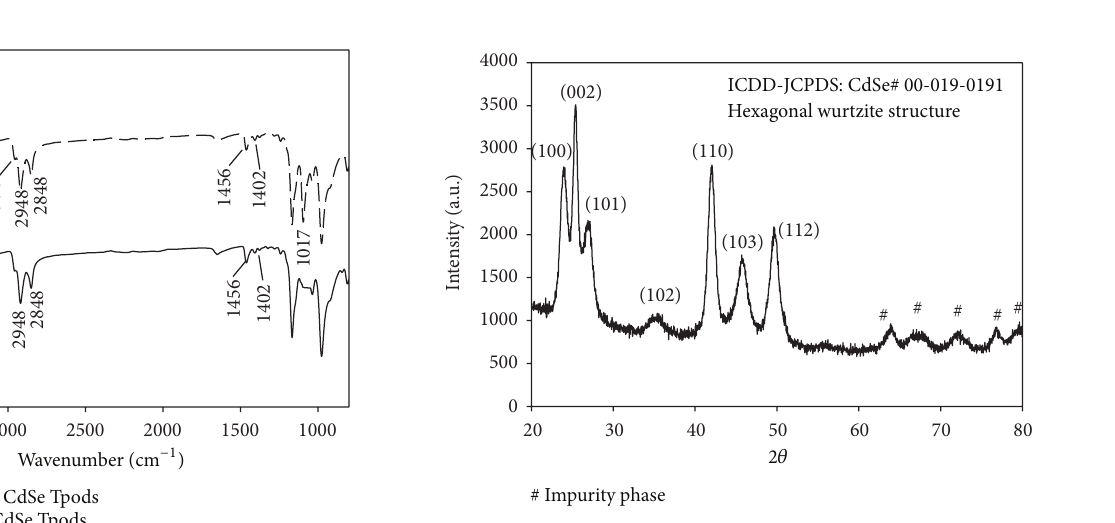
Figure 1: (a) Transmission electron microscopic image and (b) high-resolution transmission electron microscopic image of CdSe tetrapod nanocrystals.